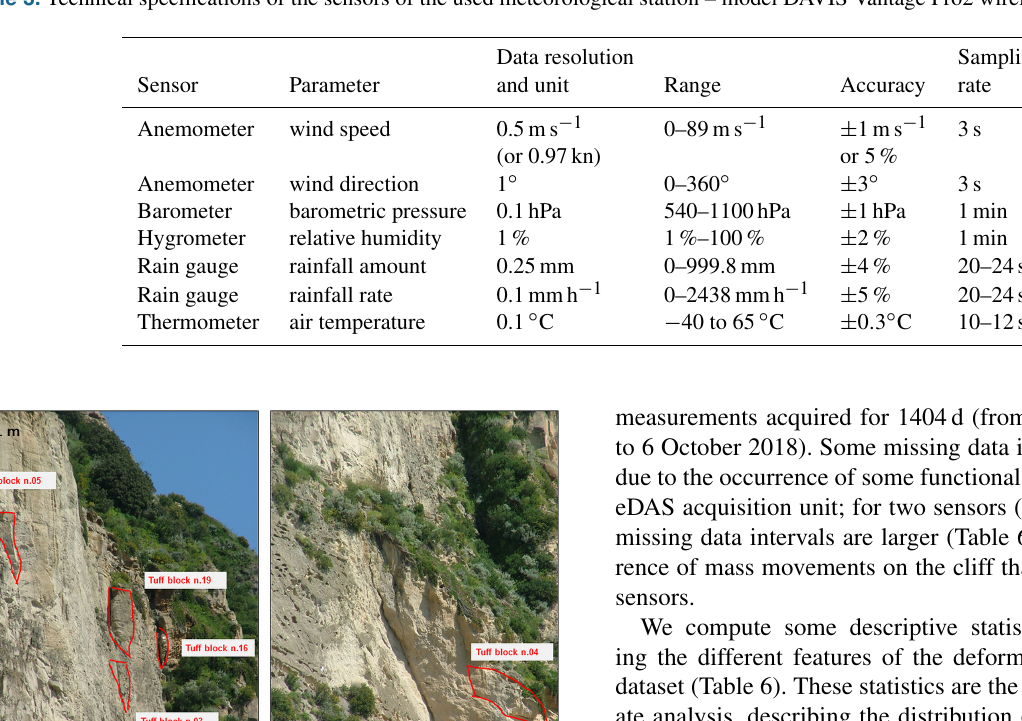
Table 3. Technical specifications of the sensors of the used meteorological station – model DAVIS Vantage Pro2 wireless in DeMS.